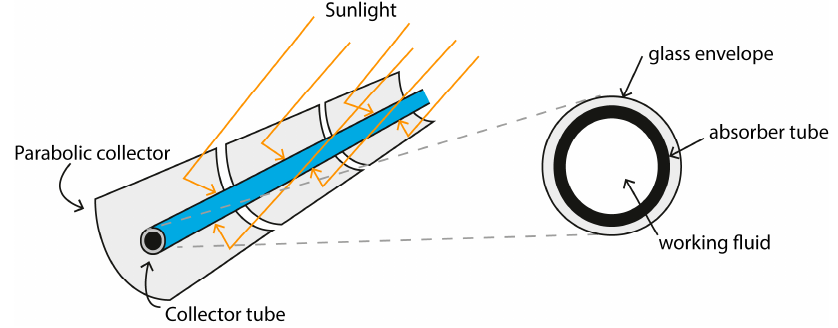
Figure 1. Illustration of functioning parabolic collector and absorber tube.